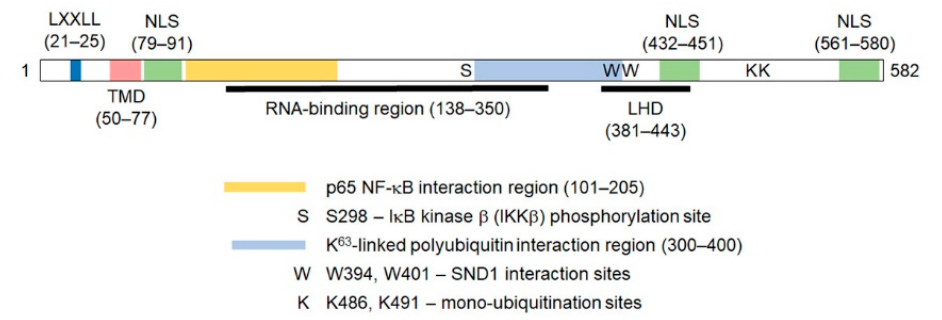
Figure 1. Diagram of the human Astrocyte elevated gene-1(AEG-1) protein showing the important motifs and regions mediating its function. The numbers indicate amino acid residues. The LXXLL motif allows AEG-1 to interact with retinoid X receptor (RXR) and inhibit RXR function. TMD: transmembrane domain. NLS: nuclear localization signal. LHD: lung homing domain. The K63- linked polyubiquitin interaction region mediates the interaction with the upstream molecules of the NF-B pathway, such as receptor interacting serine/threonine kinase 1 (RIP1). See text for more details.